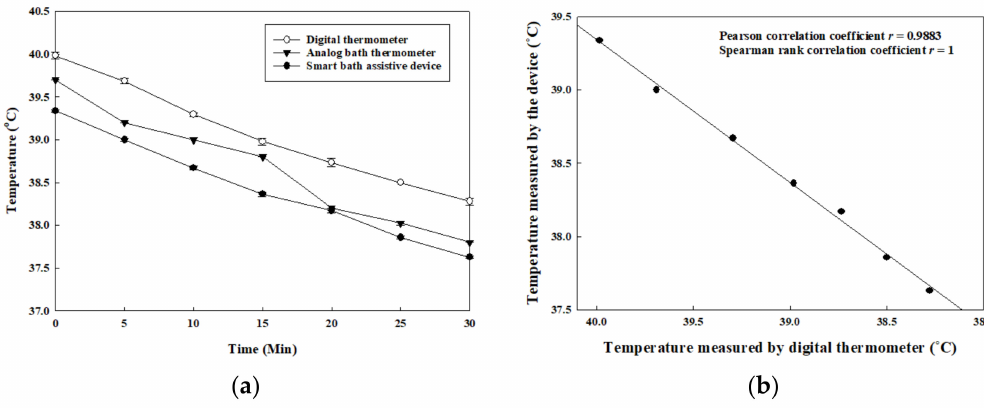
Figure 9. Graphs of the experiment results for comparison of proposed device, a commercial analog bath thermometer, and a digital thermometer for water temperature measurement: (a) water temperatures measured by the three devices; (b) Pearson and Spearman correlations of the proposed device and the digital